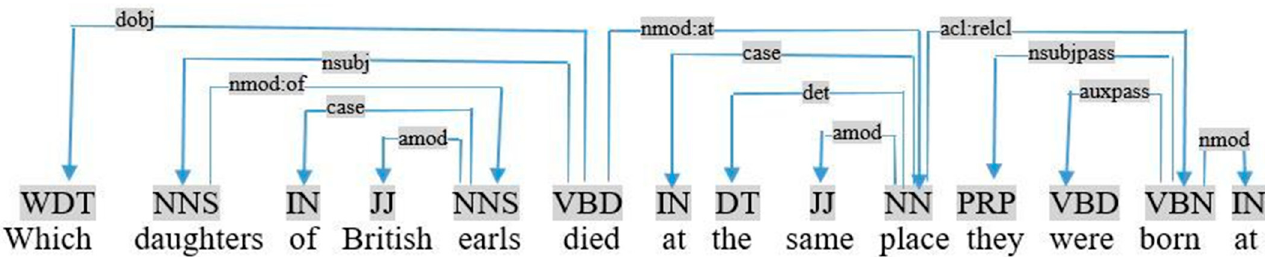
Figure 13. Graph dependency of the query «which daughters of British earls died at the same place they were born at».